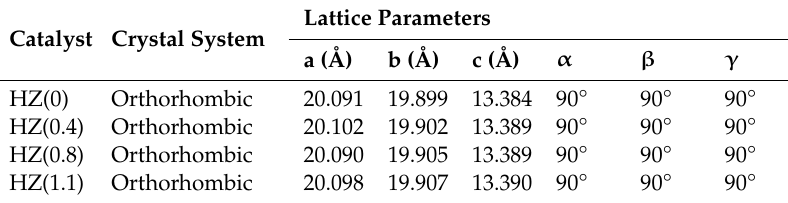
Table 1. Crystallite and lattice parameters of catalysts.